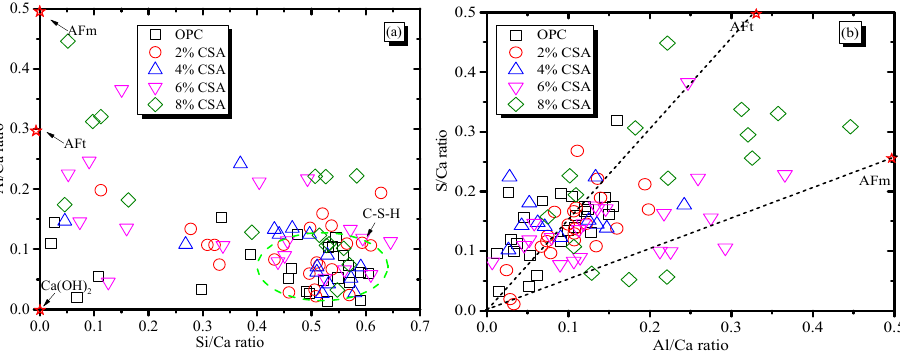
Figure 10. BSE/EDS plots of the atomic ratios for cement, ( a ) Al/Ca vs. Si/Ca ( b ) S/Ca vs. Al/Ca.